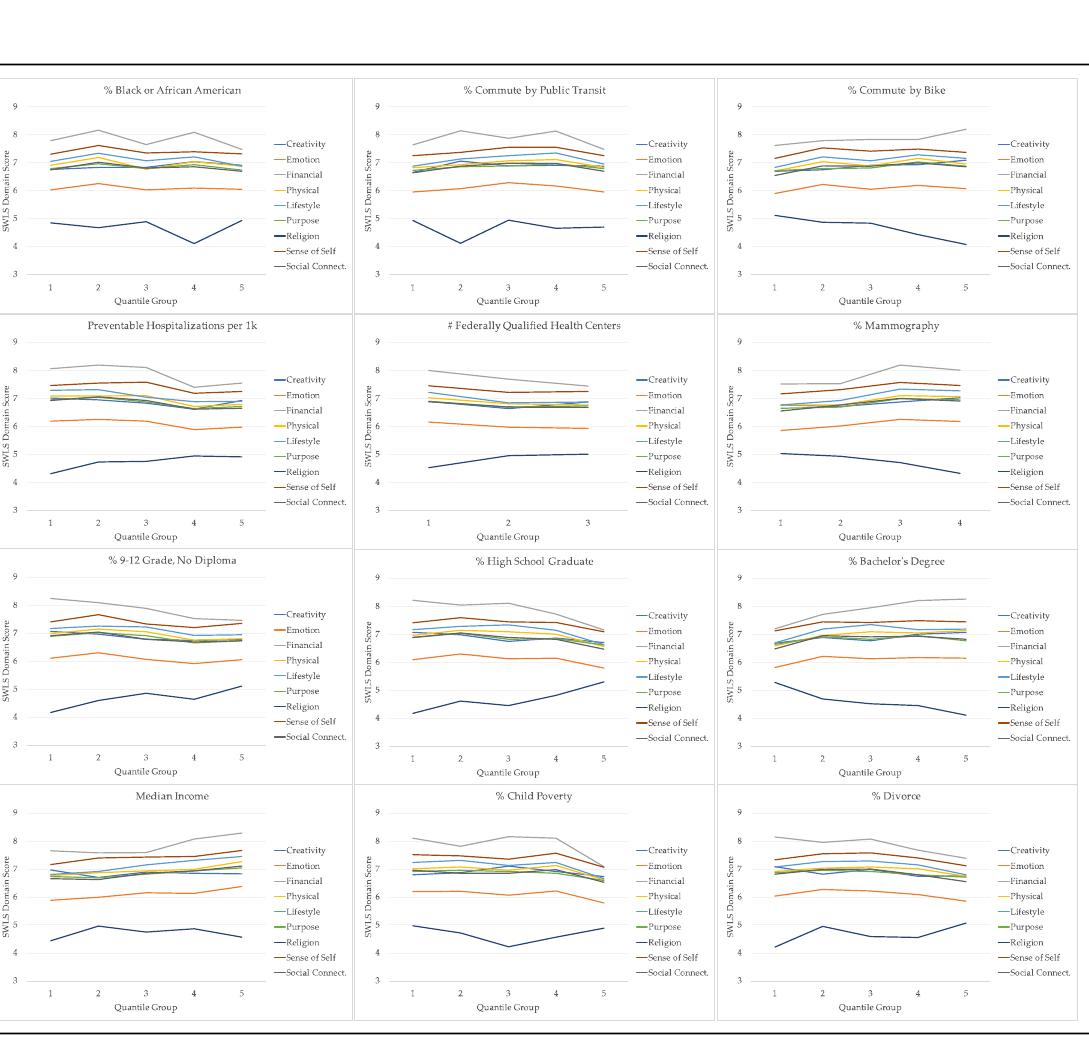
Figure 1. Average SWLS domain scores by neighborhood factor quantile group.